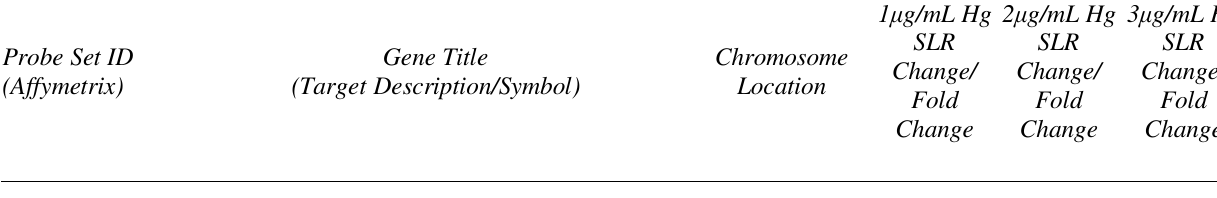
Table 1 contd.: Sample genes affected by mercury.